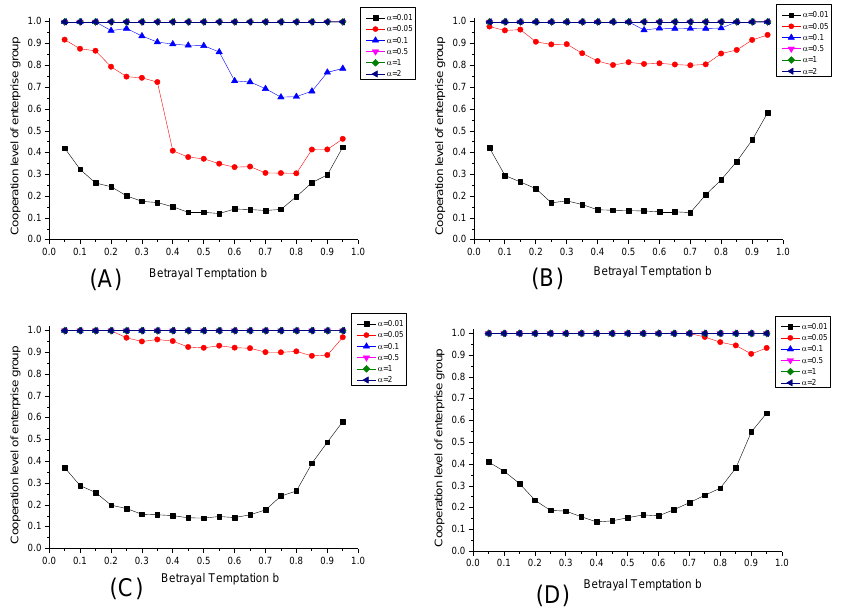
Figure 6. The evolutionary equilibrium under different corporate reputation sensitivity. Note: r = 0.3, and ( A ) u = 0.1; ( B ) u = 0.3; ( C ) u = 0.5; ( D ) u = 0.7.